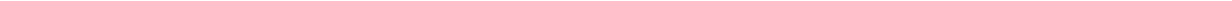
Fig. 7 HBV-STAT3-SALL4 axis inhibits miR-200c transcription. a The mRNA and protein levels of SALL1, SALL2 and SALL4 of HBV + HLCZ01 cells were determined by q-RT-PCR (upper) and western Blot (below). b miR-200c expression was determined in HBV + HLCZ01 cells transfected with si- SALL1 , si- SALL2 , and si- SALL4 (left), miR-200c expression was determined in HBV + HepaRG cells transfected with si- SALL4 (right). c PD-L1 expression was assayed by FACS in HBV + HLCZ01 cells transfected with si- SALL4 . d miR-200c expression was determined in HBV + HLCZ01 cells transfected with SALL4 over- expressing vector. e PD-L1 expression was assayed in SALL4 over-expressed HBV + HLCZ01 cells. f The mRNA level of SALL4 in HBV + HepaRG cells was determined by q-RT-PCR. g PD-L1 expression was assayed by FACS in HBV + HepaRG cells transfected with si- SALL4 . h PD-L1 expression was assayed by FACS in HBV + HepaRG cells transfected with SALL4 over-expressing vector. i The activity of the miR-200c promoter reporter was assayed. j ChIP with SALL4 antibody showed binding of SALL4 to the miR-200c promoter in the HBV-infected H LCZ01 cells. Data are representative of three independent experiments. Signi fi cant differences calculated using unpaired two-tailed Student ’ s t -tests. * P < 0.05, ** P <